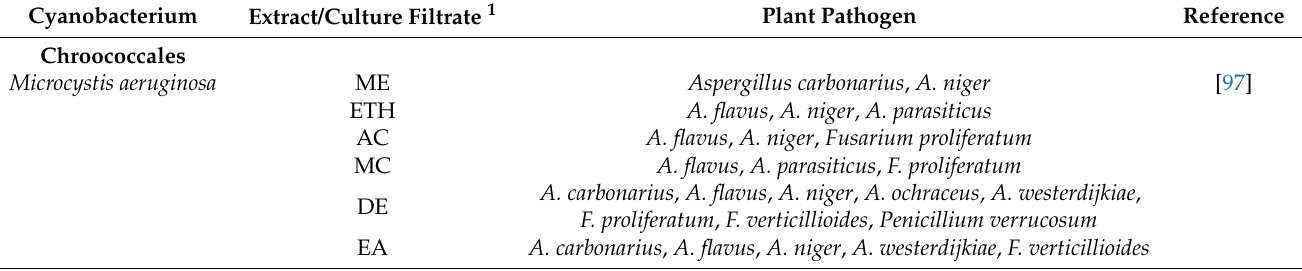
Table 1. Activity of extracts and culture filtrates from cyanobacteria against phytopathogenic fungi and oomycetes in agar medium